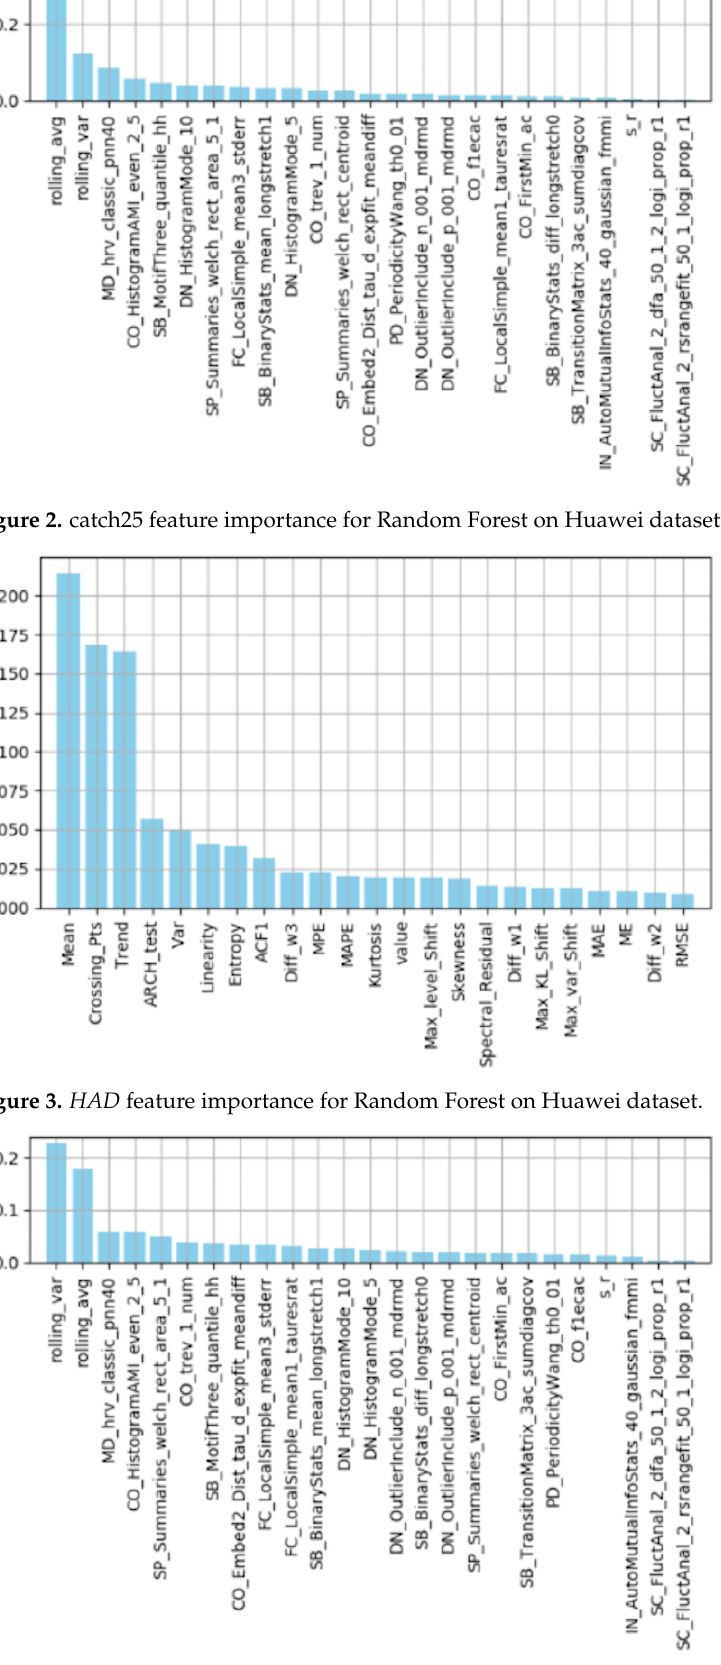
Figure 4. catch25 feature importance for Random Forest on IOPS